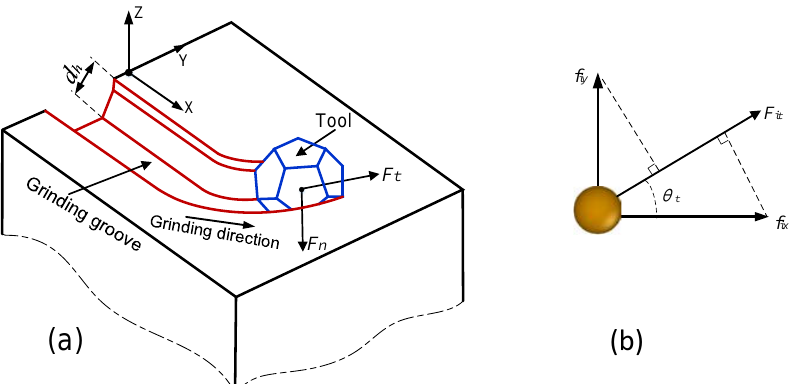
Figure 2. Schematic diagram of the curve grinding process ( a ); the sketch of the tangential grinding force of a single atom ( b ).